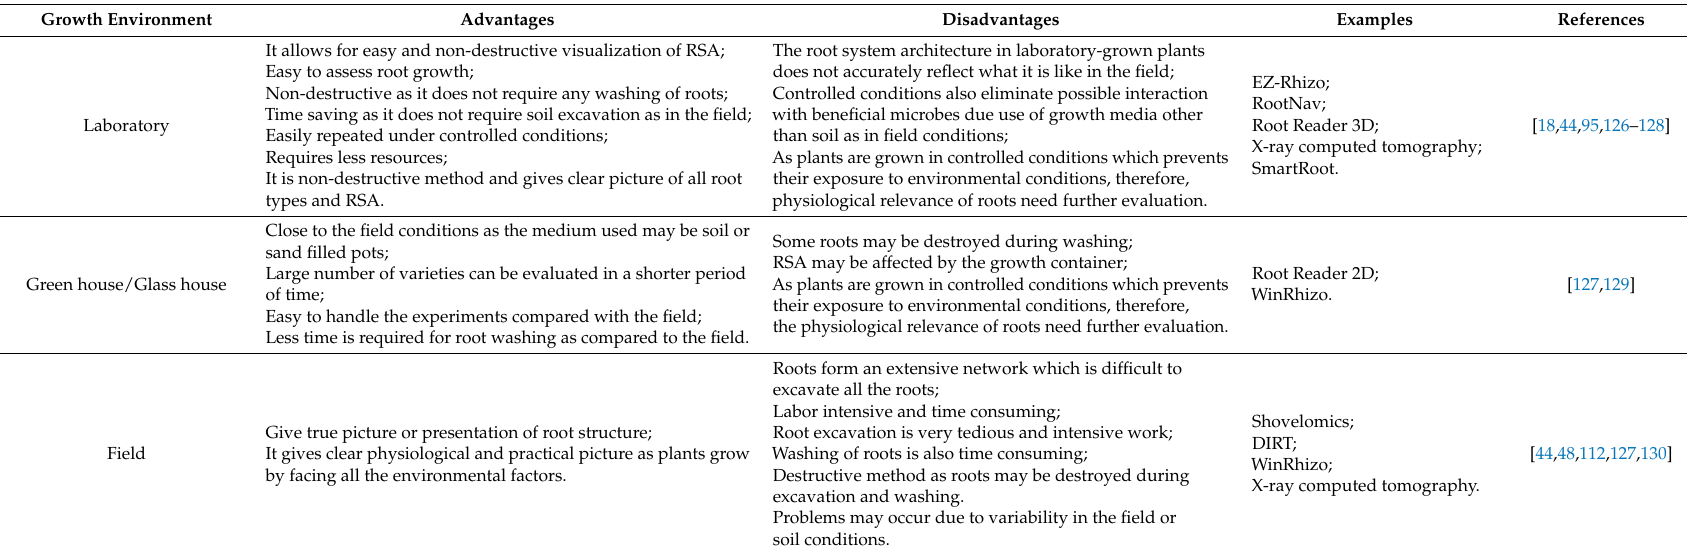
Table 2. Advantages/disadvantages of methods used for growing plants for root